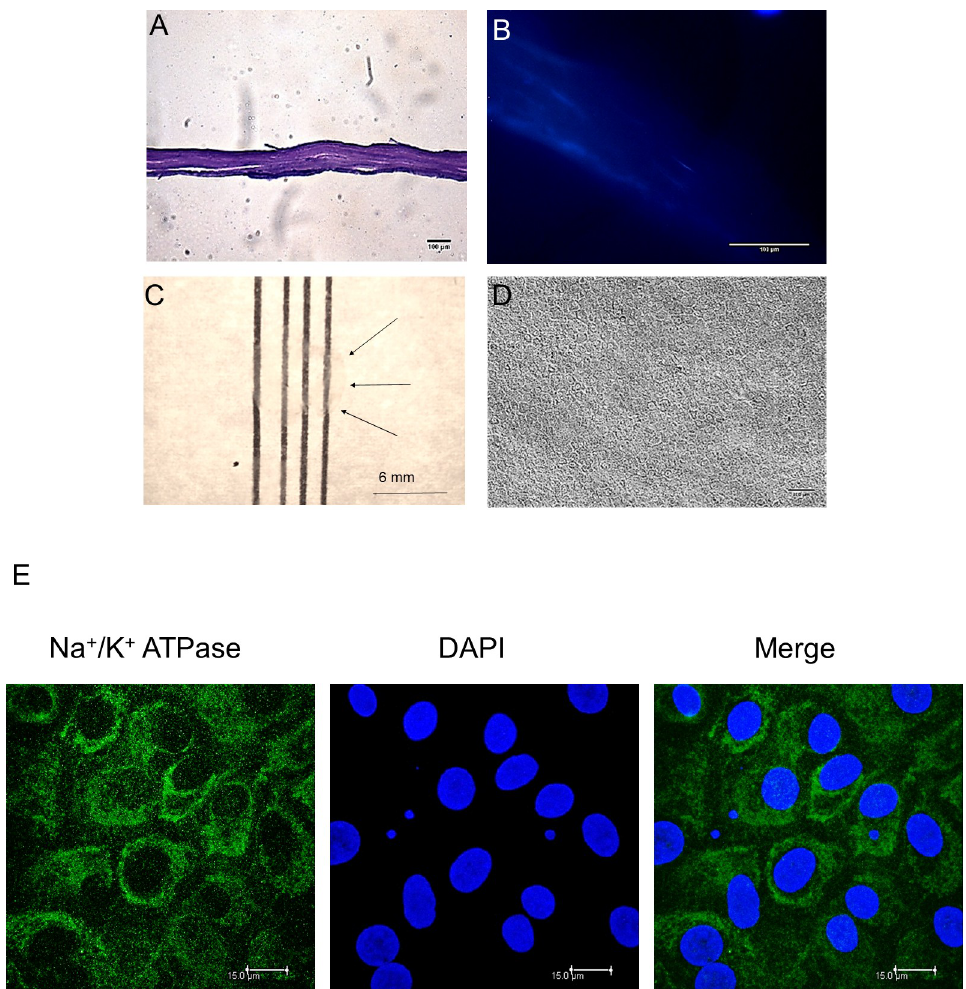
Fig 1. hCEC culture characterization. (A) Microscopic image of haematoxylin and eosin staining confirmed that the corneal stroma structure of decellularized corneal sheets was well maintained. (B) Lack of DAPI staining demonstrated the absence of cells in the scaffold. (C) Macroscopic image of decellularized lamina over a grid showing 90% transparency. (D) Phase contrast image of cultured hCECs isolated from donor corneas, showing the hexagonal morphology at passage 0. (E) Demonstration of cultured hCEC pumping function by Na + /K + -ATPase pump immunohistochemistry and confocal microscopy. Nuclei are stained with DAPI.